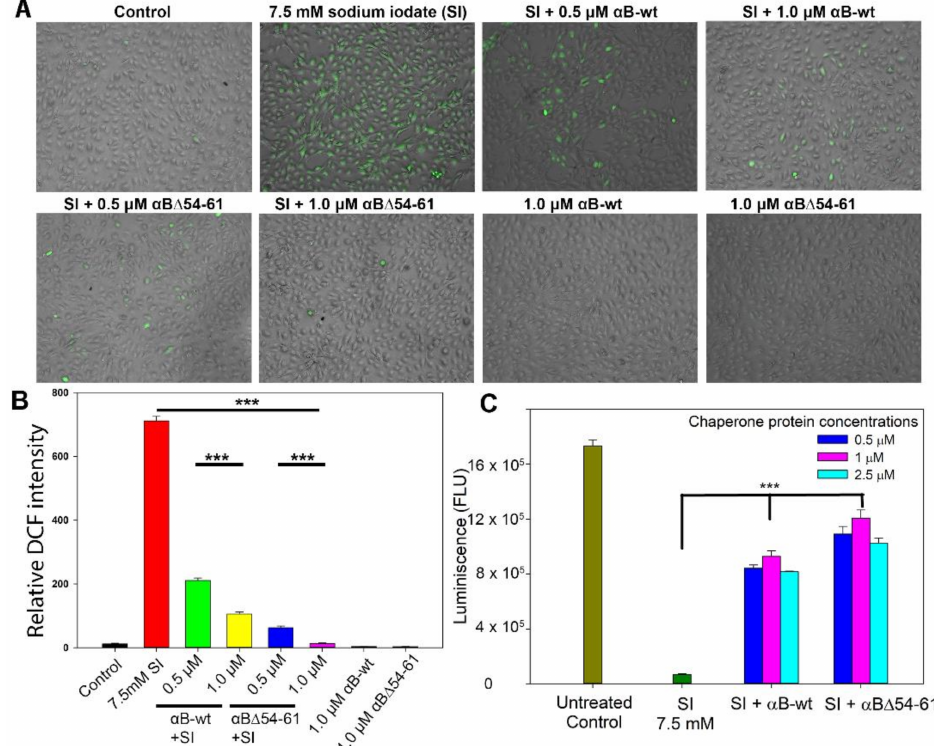
Figure 7. ( A ). Anti-oxidative potentials of α B-wt and α B ∆ 54–61 in SI-treated ARPE-19 cells. ARPE- 19 cells cultured on a 96-well plate were treated with SI and/or α B-crystallins for 24 h. The SI-induced reactive oxygen species (ROS) generation was measured by 2 (cid:48) ,7 (cid:48) -Dichlorofluorescin diacetate (DCFH- DA) staining. The images were captured in EVOS FL Auto2 Imaging System (Thermo Fisher Scientific, Waltham, MA, USA) with 10 × magnification. ( B ) The relative 2’-7’-dichlorofluorescein (DCF) intensity (green) calculated using EVOS™ image analysis software (version 1.4.998.659). ( C ) ARPE-19 cells cultured on a 96-well plate were treated with SI and/or α B-wt and α B ∆ 54–61 for 24 h. CellTiter Glo 2.0 assay was used to measure ATP, an indicator of cell health. ATP is quantified indirectly by measuring the luminescence of the cells after treatment and is expressed as relative light units (RLU/well). The data shown are an average of six analyses performed on images captured from different wells. The asterisks (***) represent a p -value <